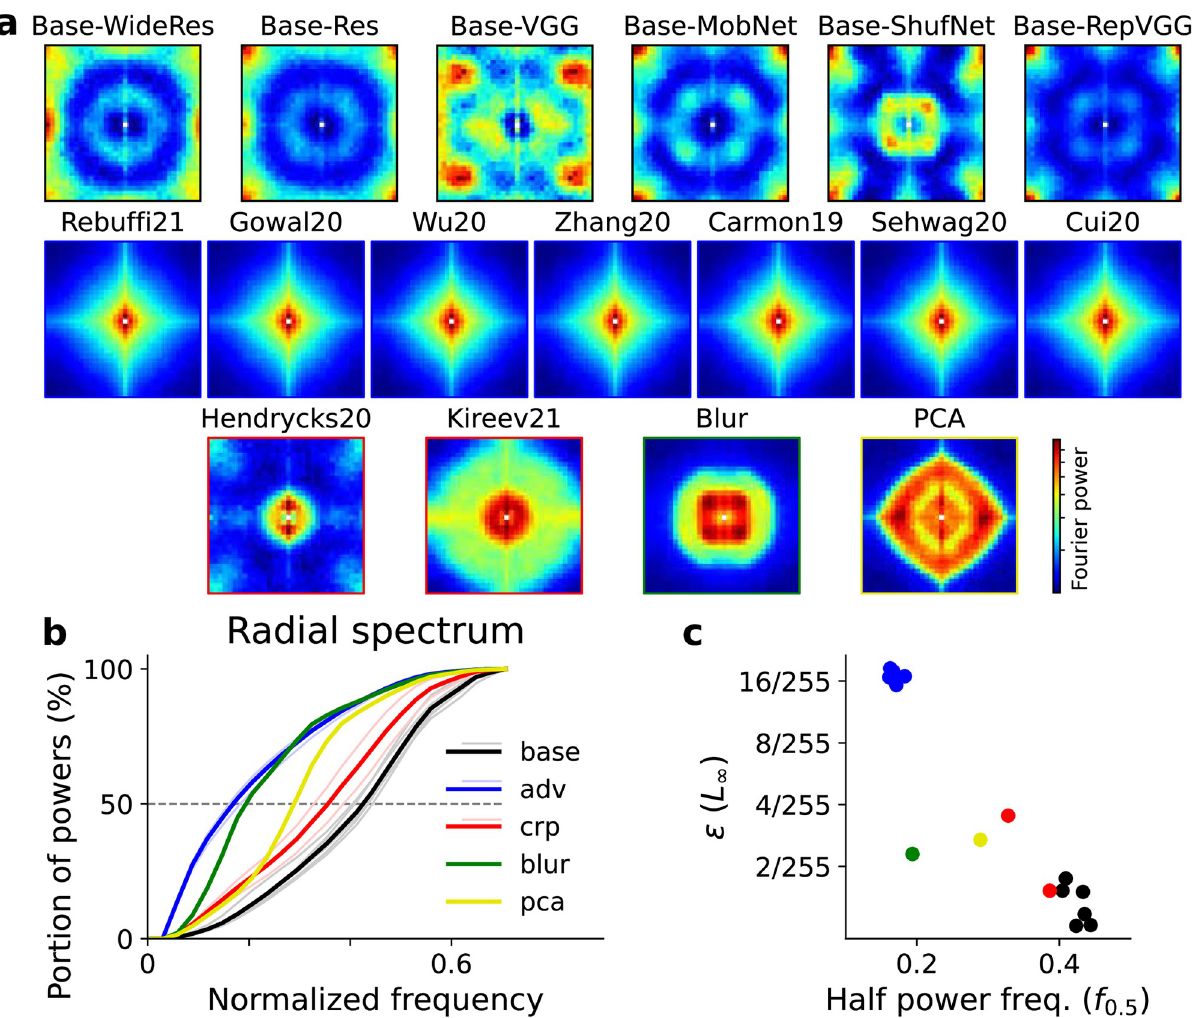
Fig 4. Frequency analysis of adversarial attacks on robust models trained on CIFAR10. (a) The Fourier spectrum of the minimal adversarial perturbations of different models, including six baseline models (‘base’), seven models trained for adversarial robustness (‘adv’), two models for corruption robustness (‘crp’), one model with preprocessing by blurring (‘blur’), and one with preprocessing by PCA compression (‘pca’). Model details are listed in Table B in S1 Appendix. The spectrum is averaged over 1000 images, and color maps are normalized separately for each panel. (b) Radial profiles of adversarial perturbation spectra. Light thin lines represent each individual model, while thick lines are the average within each group. The frequency where each line crosses 50% is denoted as half power frequency f 0.5 . (c) Scatter plot of minimum adversarial perturbation size versus f 0.5 for all